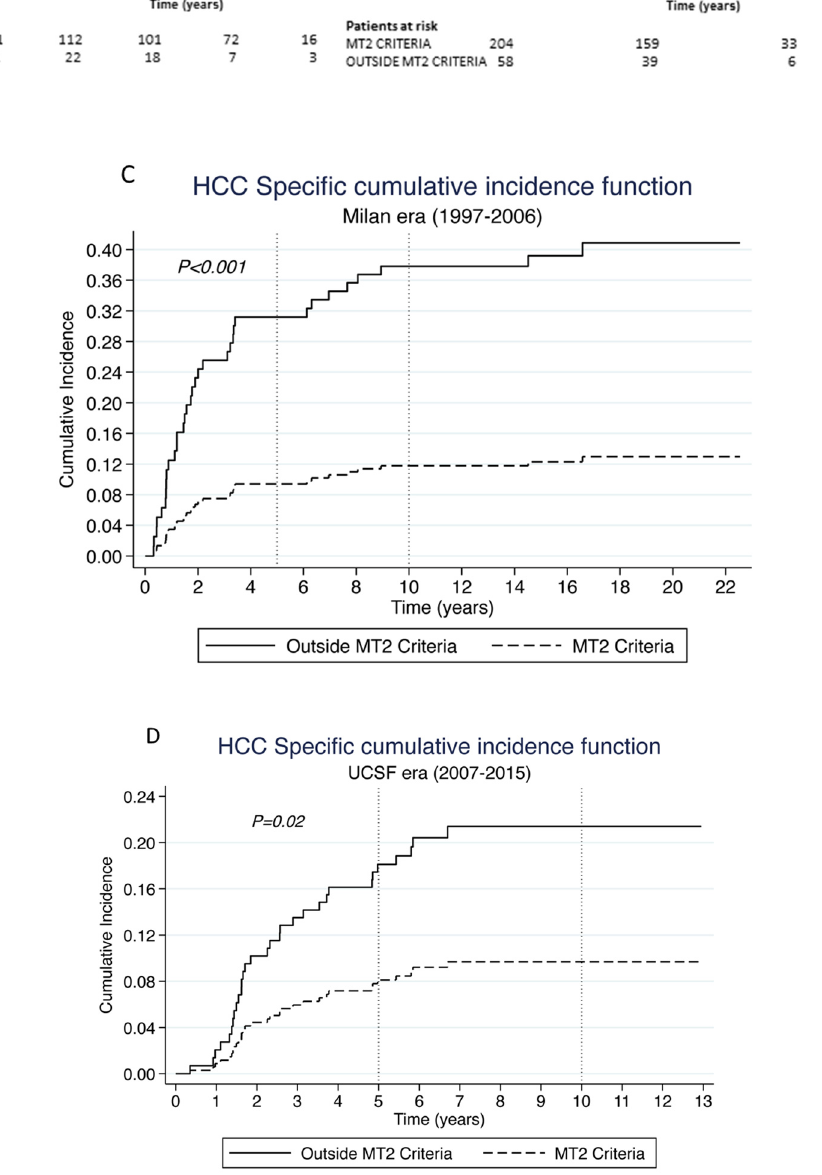
Figure 5. Kaplan–Meier Curves for Overall survival for HCC following LT comparing those within the Metroticket 2.0 criteria (red line) vs. those outside the criteria (blue line) within the ( A ) Milan and ( B ) UCSF eras , and HCC-related death following LT comparing those within the Metroticket 2.0 criteria (bold line) vs. those outside the criteria (dashed line) within the ( C ) Milan and ( D ) UCSF eras